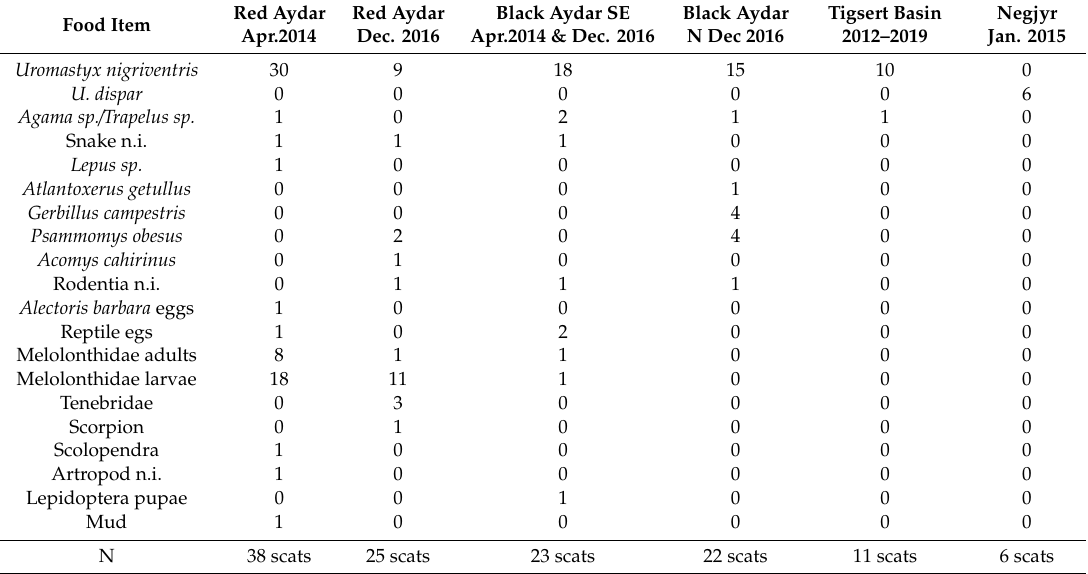
Table 1. The occurrence of the prey species in the honey badger feces (feces in which each item was